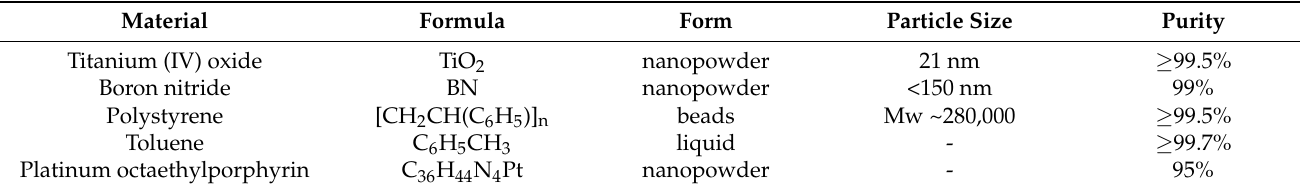
Table 1. The characteristics of materials used in the development of the